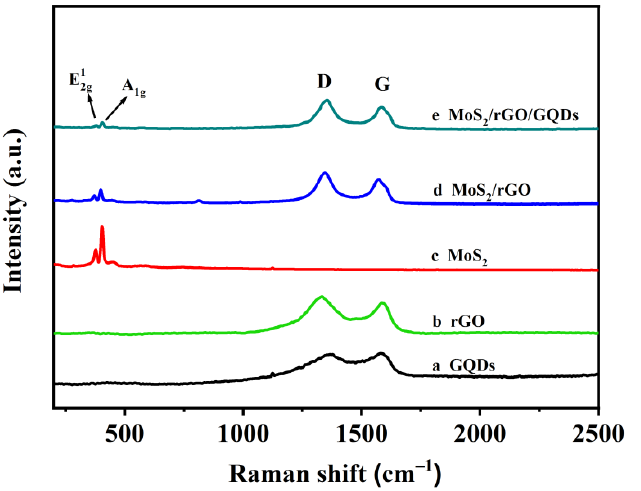
Figure 4. Raman spectra of ( a ) GQDs, ( b ) rGO, ( c ) MoS 2 , ( d ) MoS 2 /rGO, and ( e ) MoS 2 /rGO/GQDs.